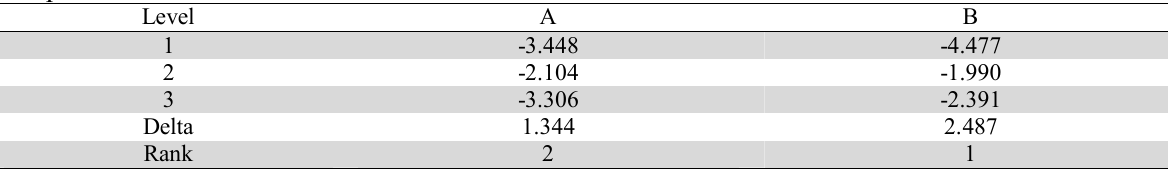
Response for S/N